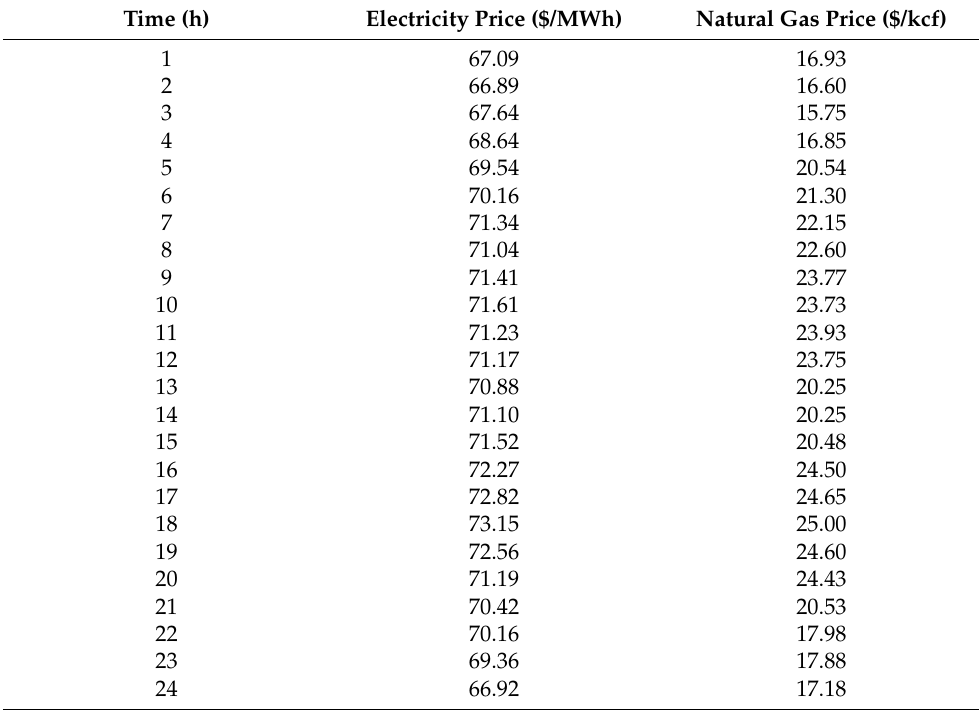
Table A6. Wholesale electricity and natural gas